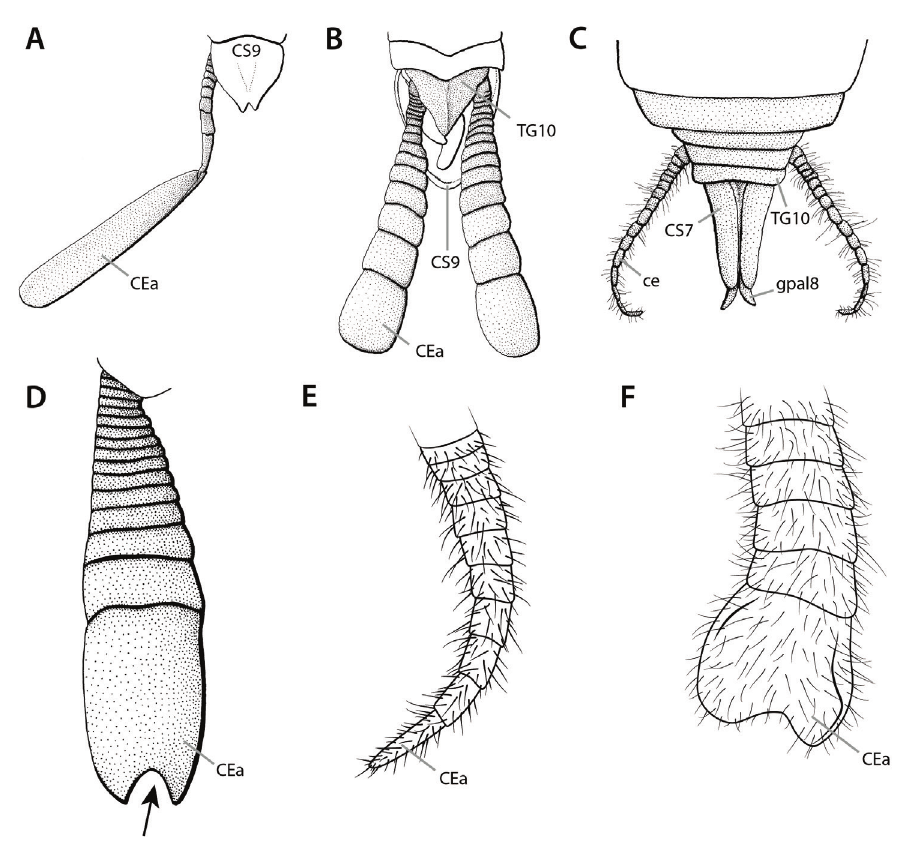
Figure 19. Morphological variation of cerci. A Amorphoscelis sp. ♂ in ventral view B Heterochaeta bernadii ♂ in dorsal view C Metallyticus splendidus ♀ in dorsal view D Toxodera maculata ♀ left cercus in dorsal view E Ciulfina sp. ♂ right cercus in lateral view F Acanthops sp. ♀ left cercus in dorsal view. Arrow indicates api- cal notch in distal cercomere. A – D reproduced and adapted from Wieland (2013). Abbreviations: ce = cer- cus; CEa = distal cercomere; CS7 = coxosternite 7 (= female subgenital plate); CS9 = coxosternite 9 (= male subgenital plate); gpal8 = apical lobe of gonapophysis 8; TG10 = tergite 10 (= supraanal plate). Not to